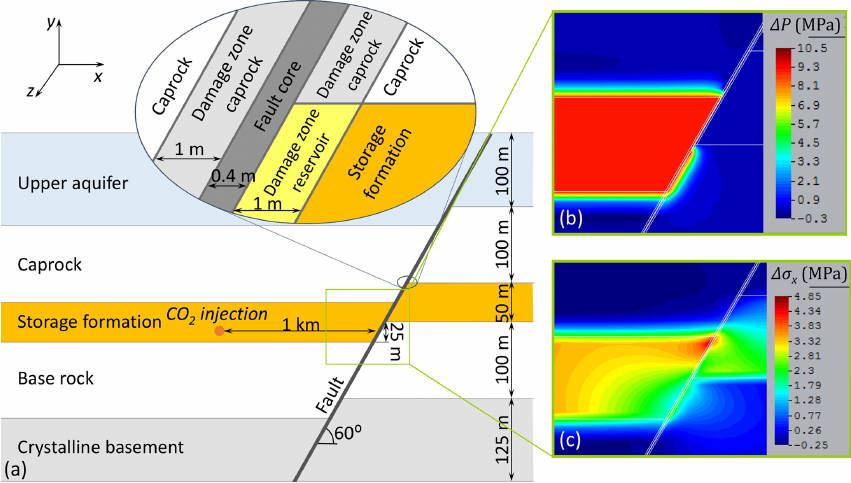
Figure 6. (a) Geological setting in a normal-faulting stress regime (plane strain model), including a low-permeability fault that leads to (b) reservoir pressurization, (cid:49)P , and (c) horizontal total stress changes in the in-plane direction, (cid:49)σ x , when CO 2 is injected in the hanging wall at a rate of 2 × 10 − 3 kgs − 1 m − 1 for 1 year.